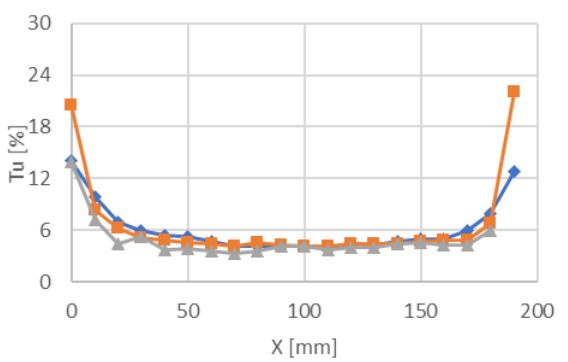
Fig. 12. Turbulent intensity, mean velocity of 14 m/s .